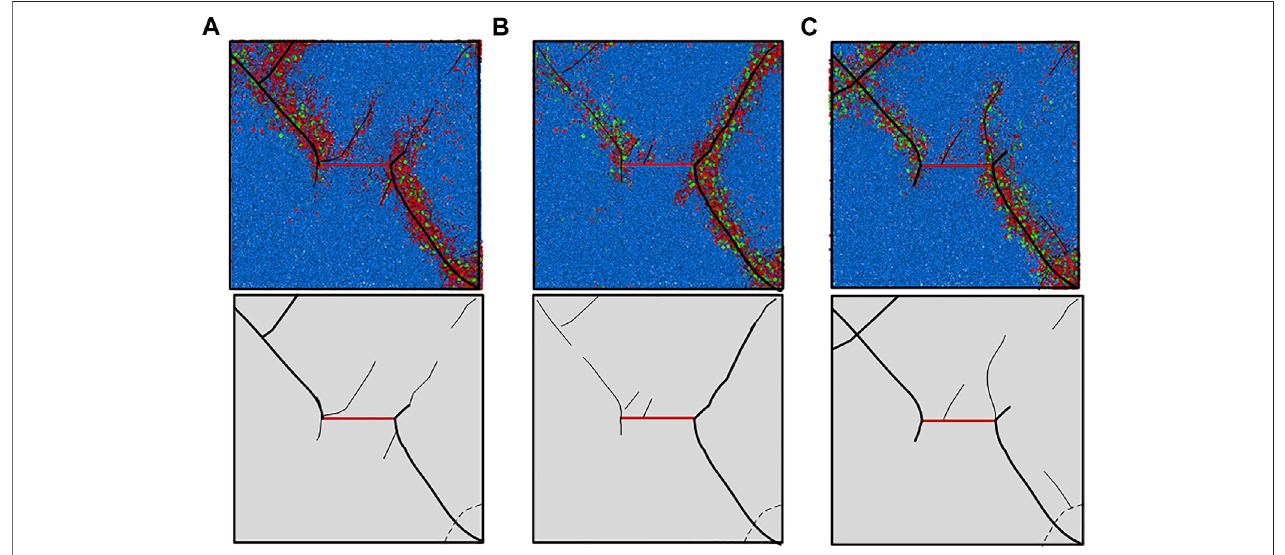
FIGURE 10 | Simulation results and sketch of specimens under different water content after loading. (A) Dry; (B) natural; (C) saturation.